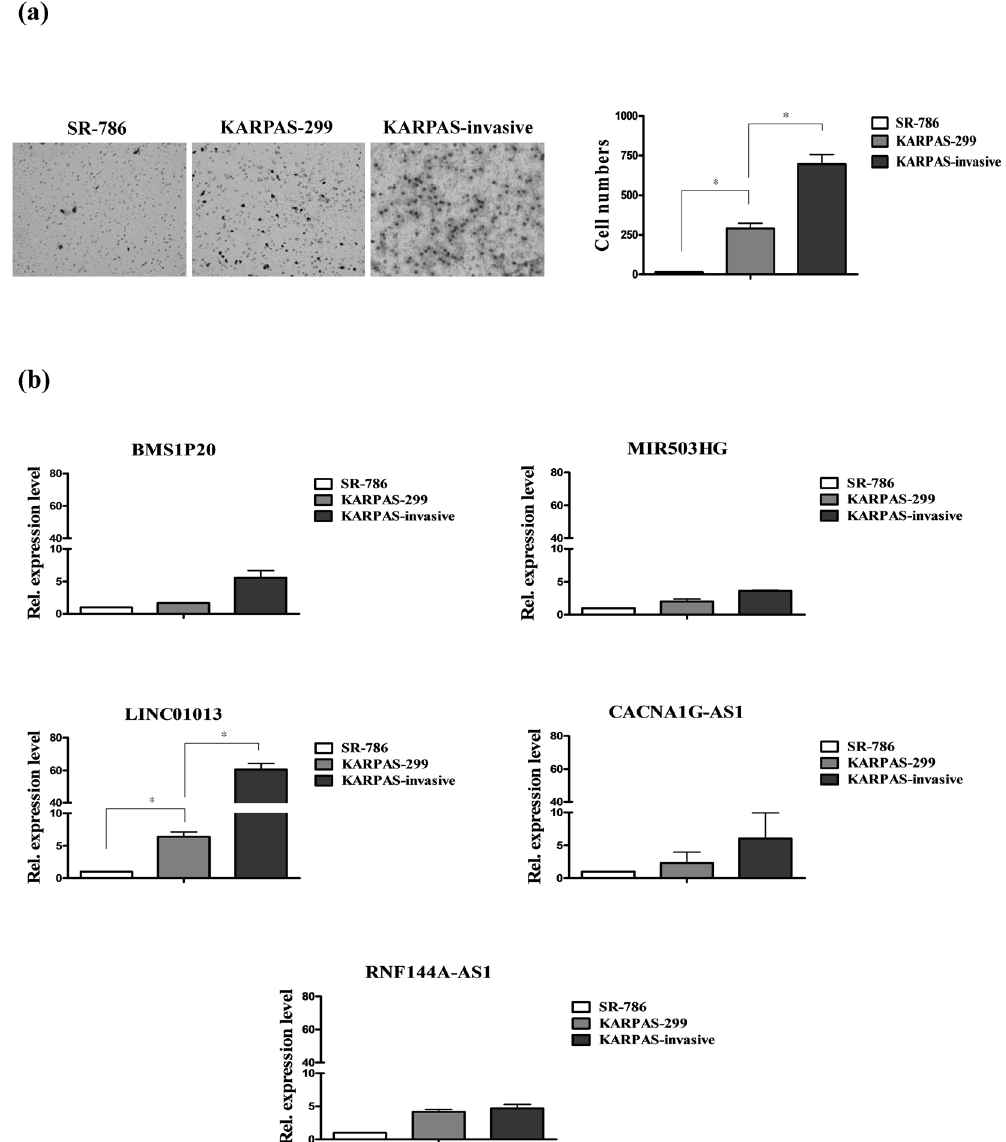
Figure 2. LINC01013 is associated with tumor-invasive functions. ( a ) Left panel : Invasion ability was analyzed in SR-786, KARPAS-299, and KARPAS-invasive cell lines using Transwell assays. Invasion activity was determined by counting the number of cells traversing the Matrigel to the lower chamber. Transwell filters were stained with crystal violet. Right panel : Quantification of invasion ability. ( b ) BMS1P20, LINC01013, MIR503HG, RNF144A-AS1 and CACNA1G-AS1 expression levels in three cell lines were measured by q-RT- PCR. Differences were analyzed using a Kruskal-Wallis test ( * P <